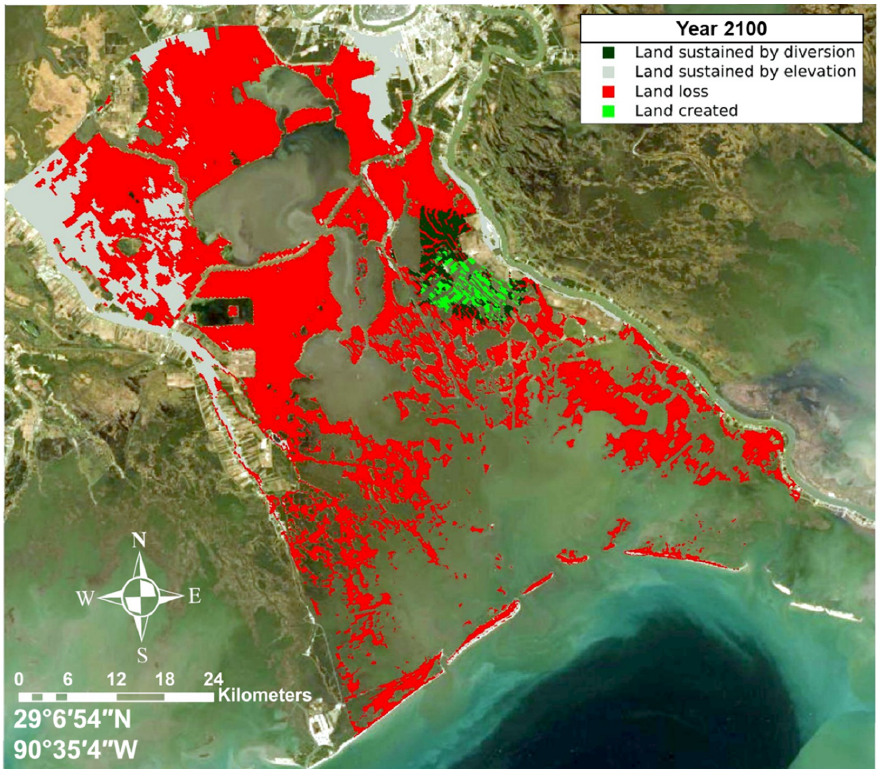
Figure 5. Net land change map by 2100. Red represents pixels that started as marsh in 2020 and converted to water by 2100 with or without the diversion, whereas grey are pixels that started as marsh in 2020 and remained as marsh by 2100 with or without the diversion. The dark green represents a pixel that started as marsh in 2020 and converted to water by 2100 without the diversion but was sustained as marsh only due to the presence of the diversion. The light green represents a pixel that started as open water in 2020 and remained water without the diversion but converted to marsh due the presence of the diversion. This particular permutation had the following attributes: subsidence: CMP17, SLR 1-m; sediment rating curve: HYST; and accretion rate of 5-mm and operation date of 2025.